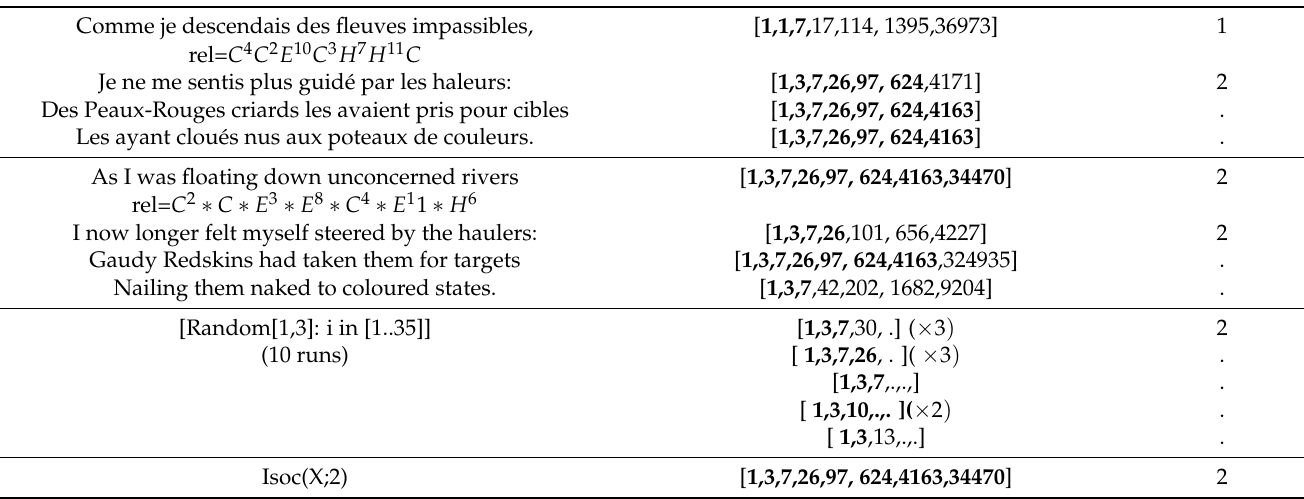
Figure 4. Part of the poem Le Bateau Ivre of Arthur Rimbaud on a wall (Rue Férou) in Paris. Table 6. Group structure of the poem Le Bateau Ivre’ ( The Drunken Boat ) by Arthur Rimbaud. Only the first strophe (that has four lines) is analyzed, firstly in its original form, then in an English translation. Each line is split into segments encoded by the symbol H (for names and adjectives), E (for verbs) or C (for the other types: conjunctions, adverbs, prepositions, punctuation marks and so on). The group relation is displayed for the first line only.) The cardinality structure of cc of subgroups of a small index is compared to the one obtained with 10 runs of a sequence of random 3-letter words of similar length (i.e., the length